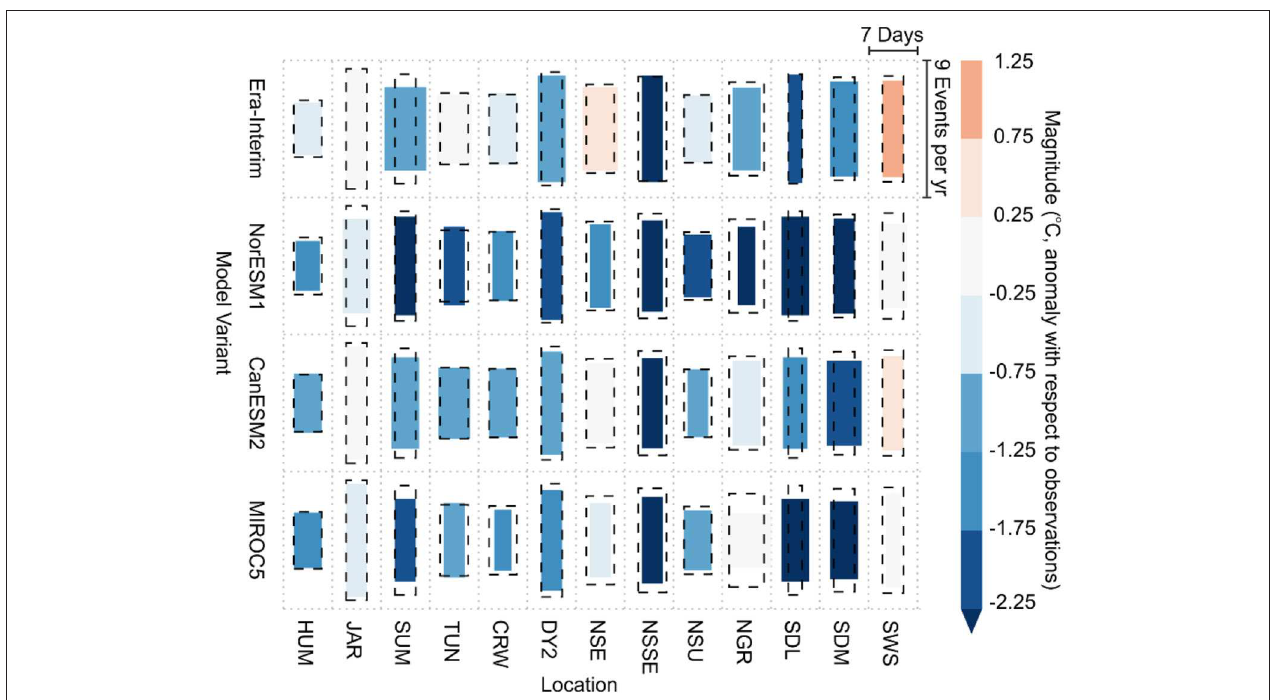
FIGURE 4 | Median frequency, duration, and magnitude of extreme temperature events simulated by four model variants at 13 locations. Frequency is denoted by the height of each box, duration is indicated by the width of each box, and observed values are given by the dashed black boxes. Box colors indicate the departure of the modeled magnitude from the observed value, blue colors indicate an underestimate, and red colors indicate an over estimate (Leeson et al.,